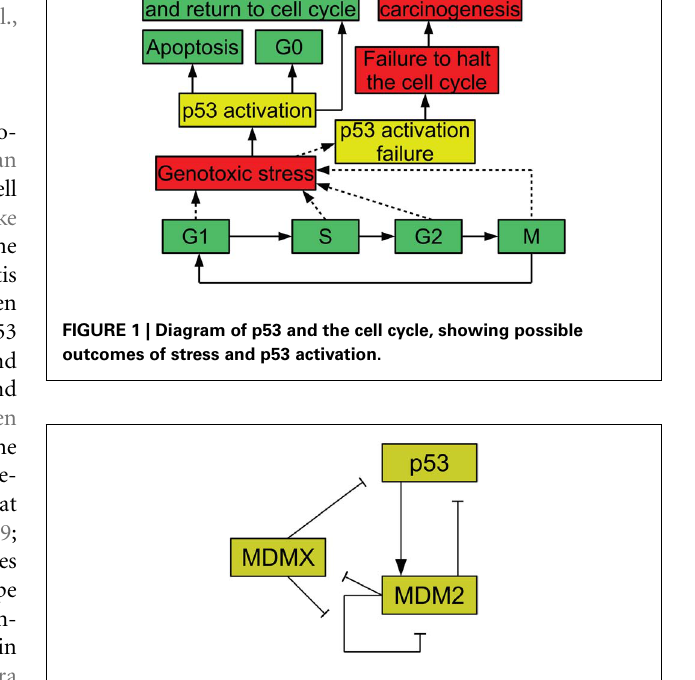
p53 levels (Haupt et al., 1997; Kubbutat et al., 1997).